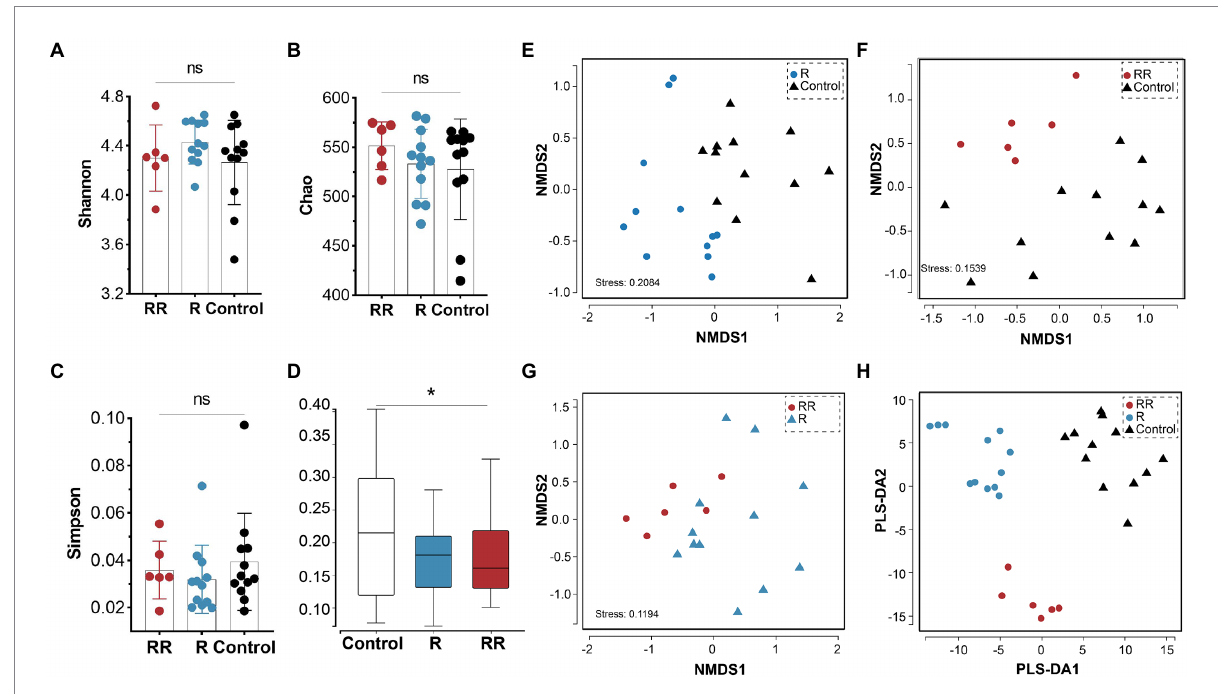
FIGURE 6 Cecal microbiota α -diversity and β -diversity following administration of R. intestinalis for 7 days (R group) or 14 days (RR group). (A) Shannon’s index. (B) Chao’s index. (C) Simpson’s index. (D) Weighted UniFrac distance of the cecal microbiota. (E–G) NMDS analysis among groups. (H) Partial least squares discrimination analysis (PLS-DA) analysis. * indicates p < 0.05, ns indicates no